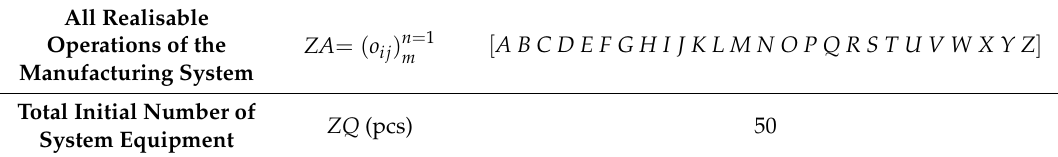
Table 2. The extent of the operational variability and the number of devices for the entire